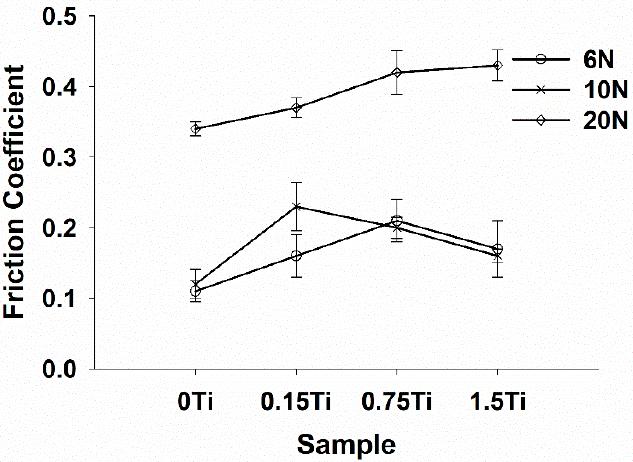
Figure 6. The difference of friction coefficients as a function of the normal loads for Mg-5Sn-xTi samples.